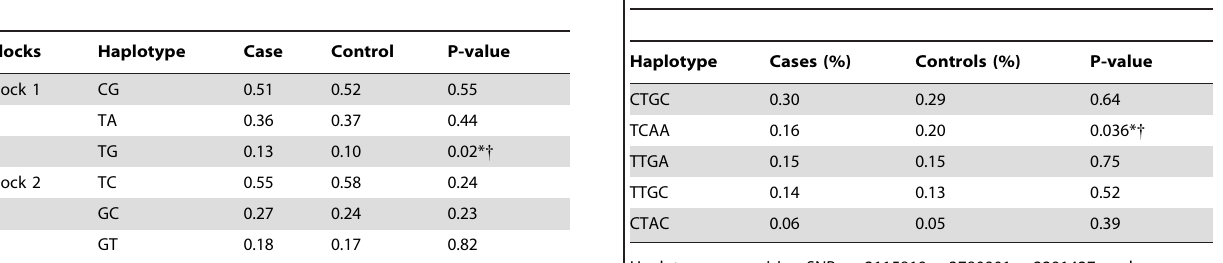
Table 5. Associations between ALOX5 haplotypes and